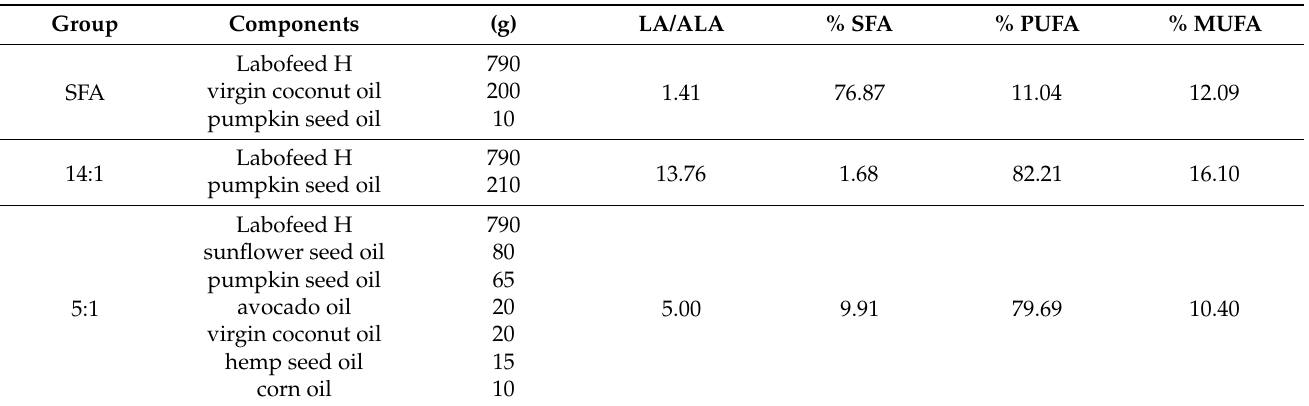
Table 1. Components of experimental